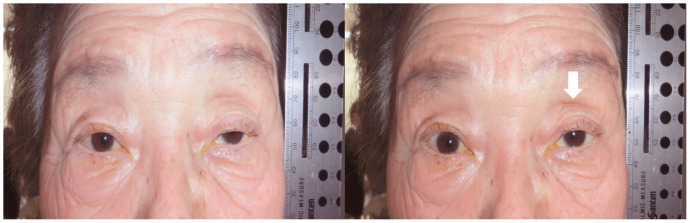
A patient with blepharoptosis judged to have a DUES-like appearance.A 79-year-old female with blepharoptosis of the left eye. A DUES-like appearance, UES and wrinkles on the forehead were all judged to be positive.